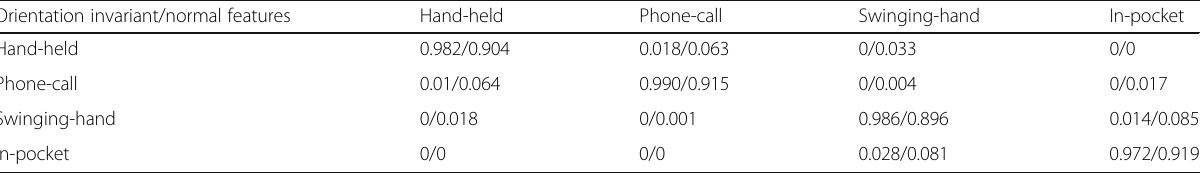
Table 1 Confusion table of random forest classifier with orientation invariant and normal features Orientation invariant/normal